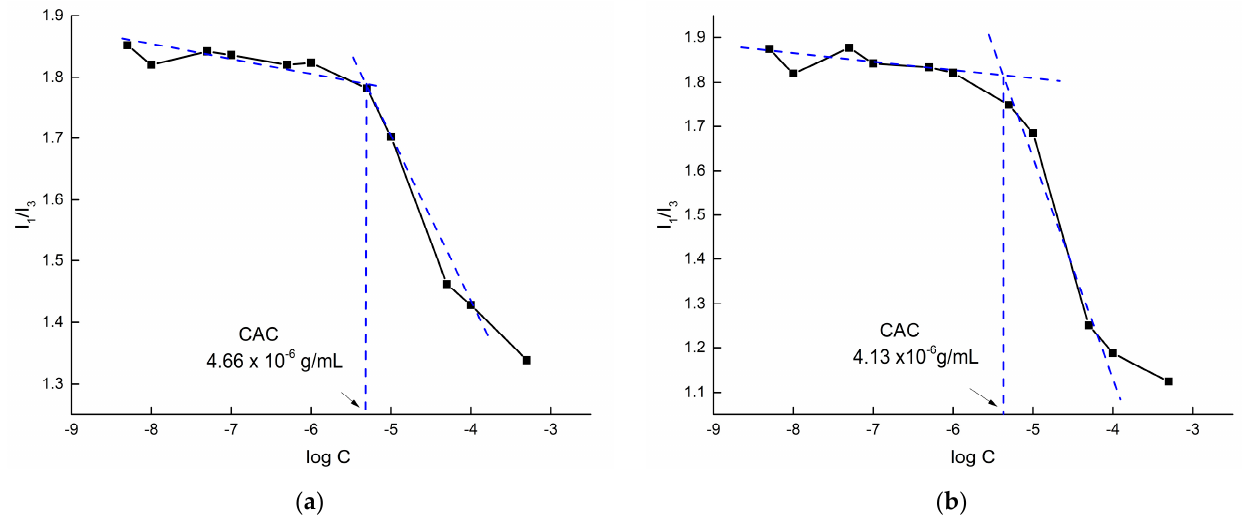
Figure 4. CAC determination for HC 1 ( a ) and HC 2 ( b ) hyperbranched copolymers in pH 7.